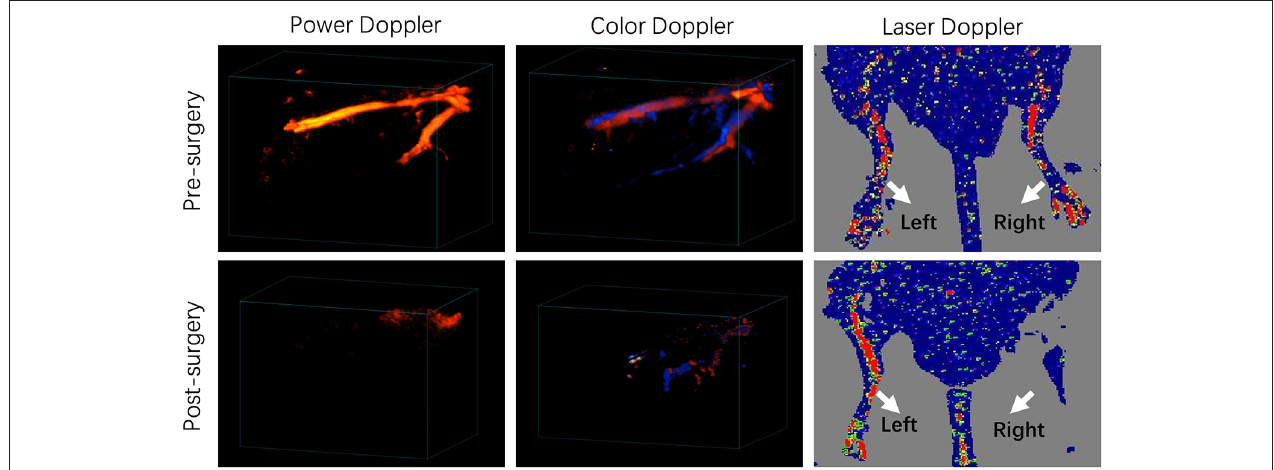
FIGURE 1 | Characterization of a murine hindlimb ischemia (HI) model. Three-dimensional power Doppler, color Doppler and Laser Doppler imaging of pre-surgery and post-surgery hindlimbs. Red and blue colors obtained by Color Doppler imaging represents blood flow with different directions, which flows toward and away from the transducer, respectively.